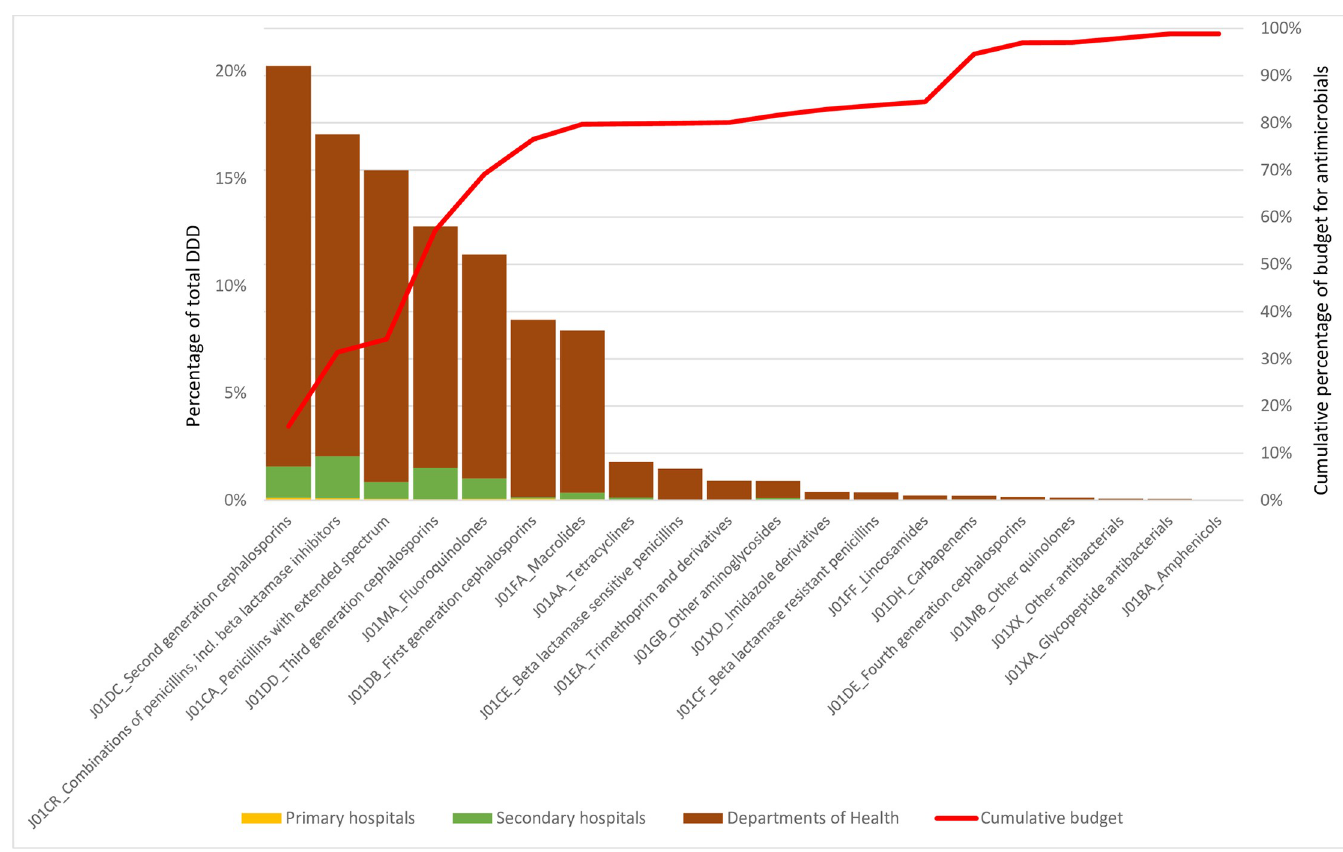
Fig 3. ABC analysis of the quantities of procured antibacterials (in DDD) and the